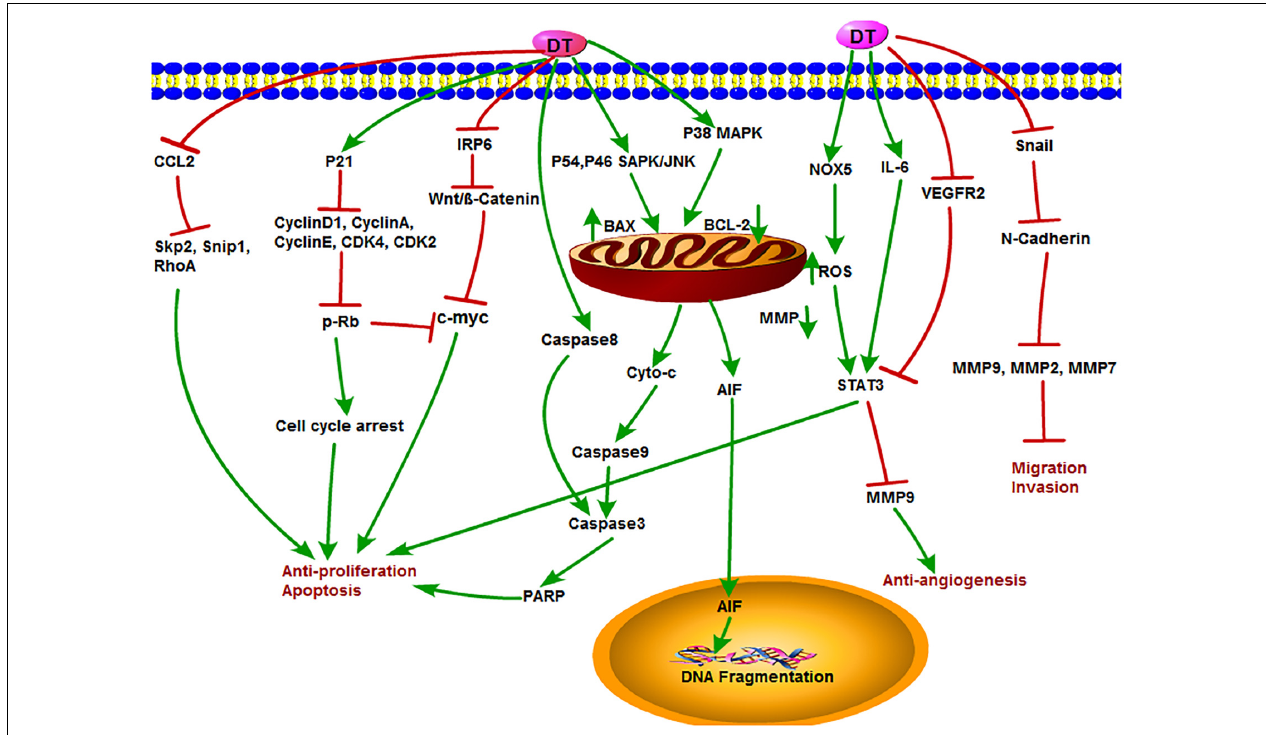
FIGURE 6 | The antitumor mechanism of DT. Dihydrotanshinone inhibits cancer cell proliferation and induces apoptosis by mediating signals such as Wnt/ β -Catenin, AMPK/Akt/mTOR, MAPK, CCL2, and p21 and inhibits the invasion and migration of cancer cells and angiogenesis by inhibiting MMP-2, MMP-9, and VEGFR2 signals. The arrow represents the promotion effect, and the T area represents the inhibition